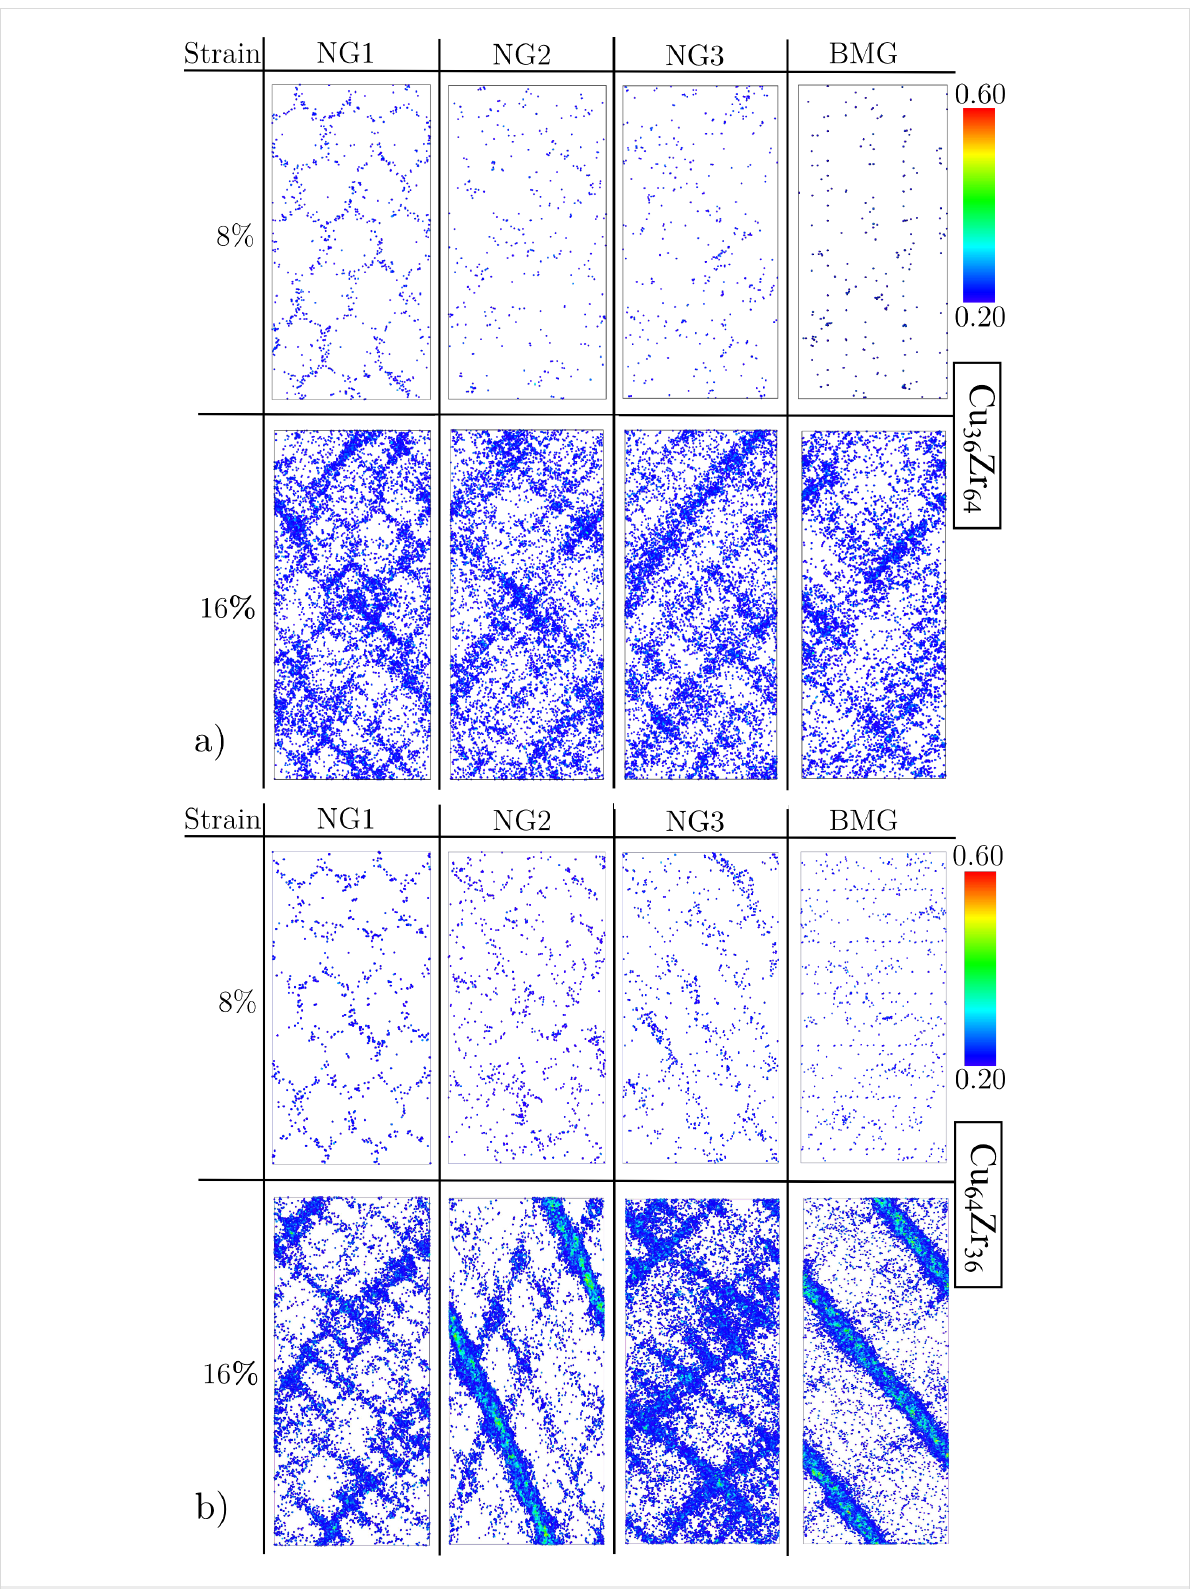
Figure 5: Local atomic shear strain for (a) Cu 36 Zr 64 and (b) Cu 64 Zr 36 BMGs and as-prepared (NG1), annealed (NG2), annealed and pre-deformed (NG3) NGs with a grain size of 10